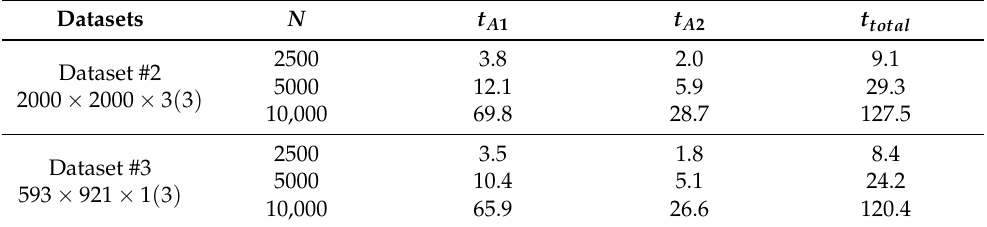
Table 4. Computational time (s) of AWSG, where t A 1 , t A 2 , and t total denote the computational time of Algorithms 1 and 2 and the whole AWSG,